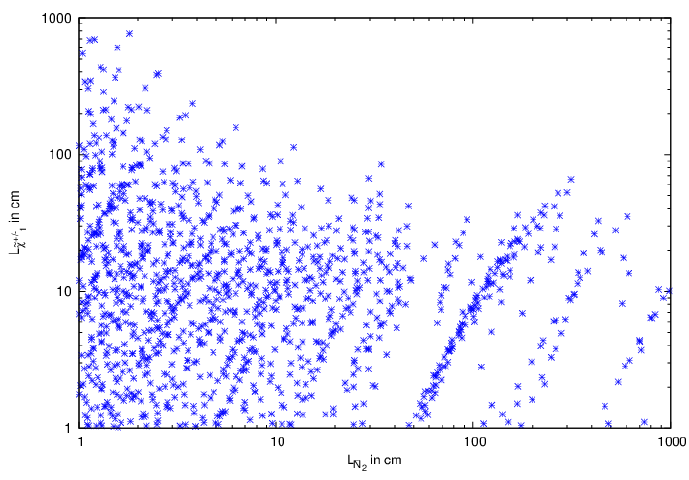
for values of the model parameters that can 1